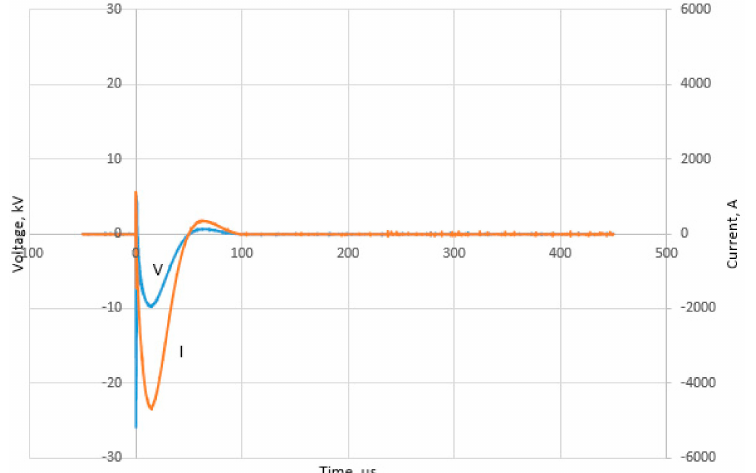
Figure 16. Voltage and current traces of negative polarity for electrodes installed at site 3, at a charging voltage of 30 kV.